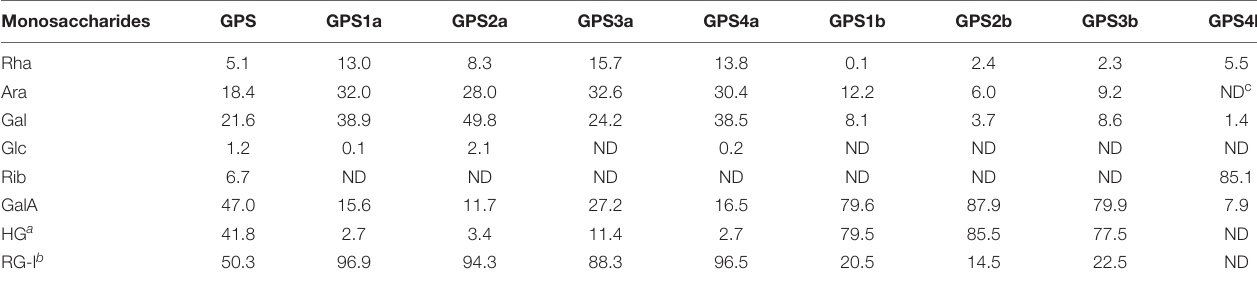
TABLE 1 | Monosaccharide compositions of Gougunao tea polysaccharide (GPS) and its purified fractions (expressed as mol%).